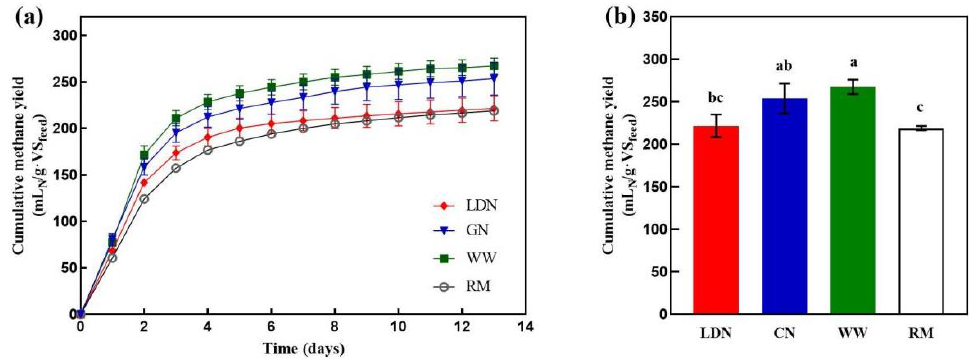
Figure 2. Effect of different neutralization treatments on BMP tests of lime-treated corn stover: ( a ) cuvers and ( b ) total yields. Data are shown as mean ± SD, n = 3. Significant differences are indicated by different letters ( p < 0.05).